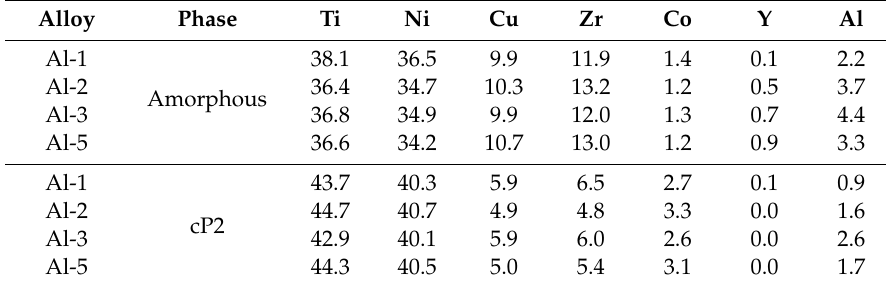
Table 2. Chemical composition of amorphous and crystalline phases studied by EDX for alloys with Al addition (in atomic percentages).